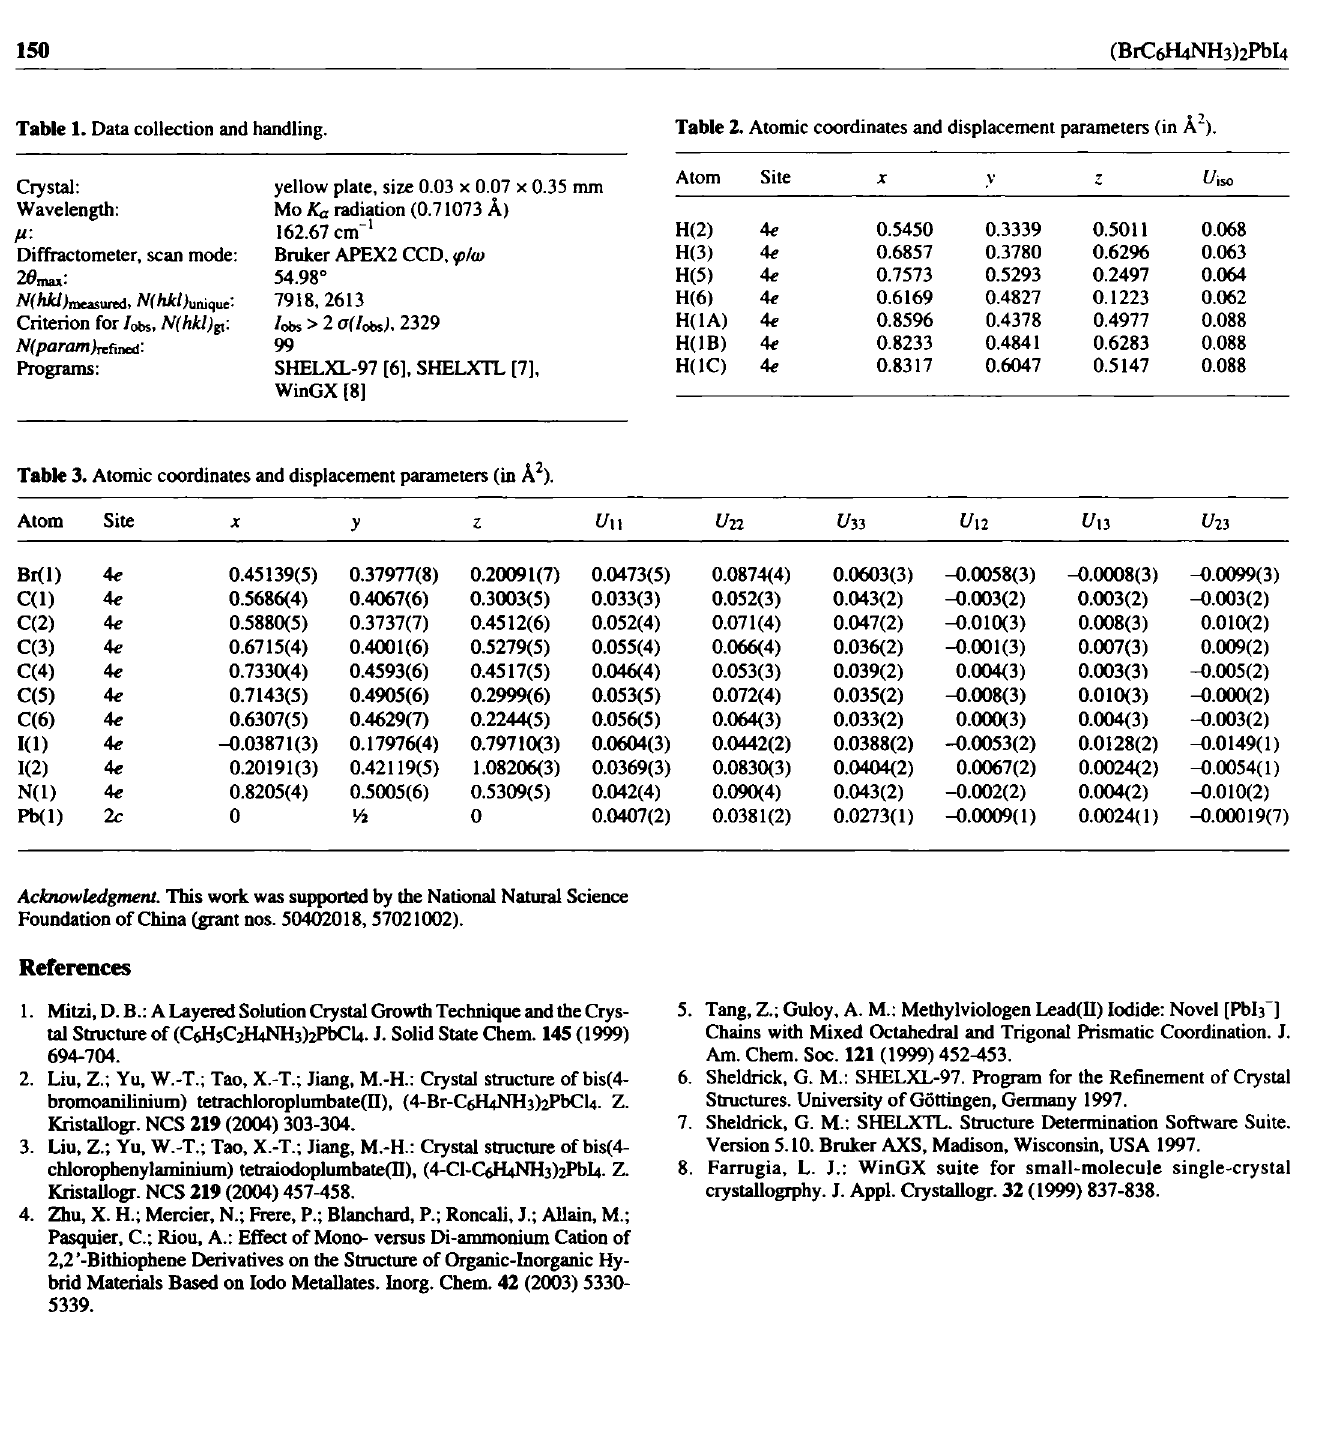
Table 1. Data collection and handling. Table 2. Atomic coordinates and displacement parameters (in Ä 2 ).